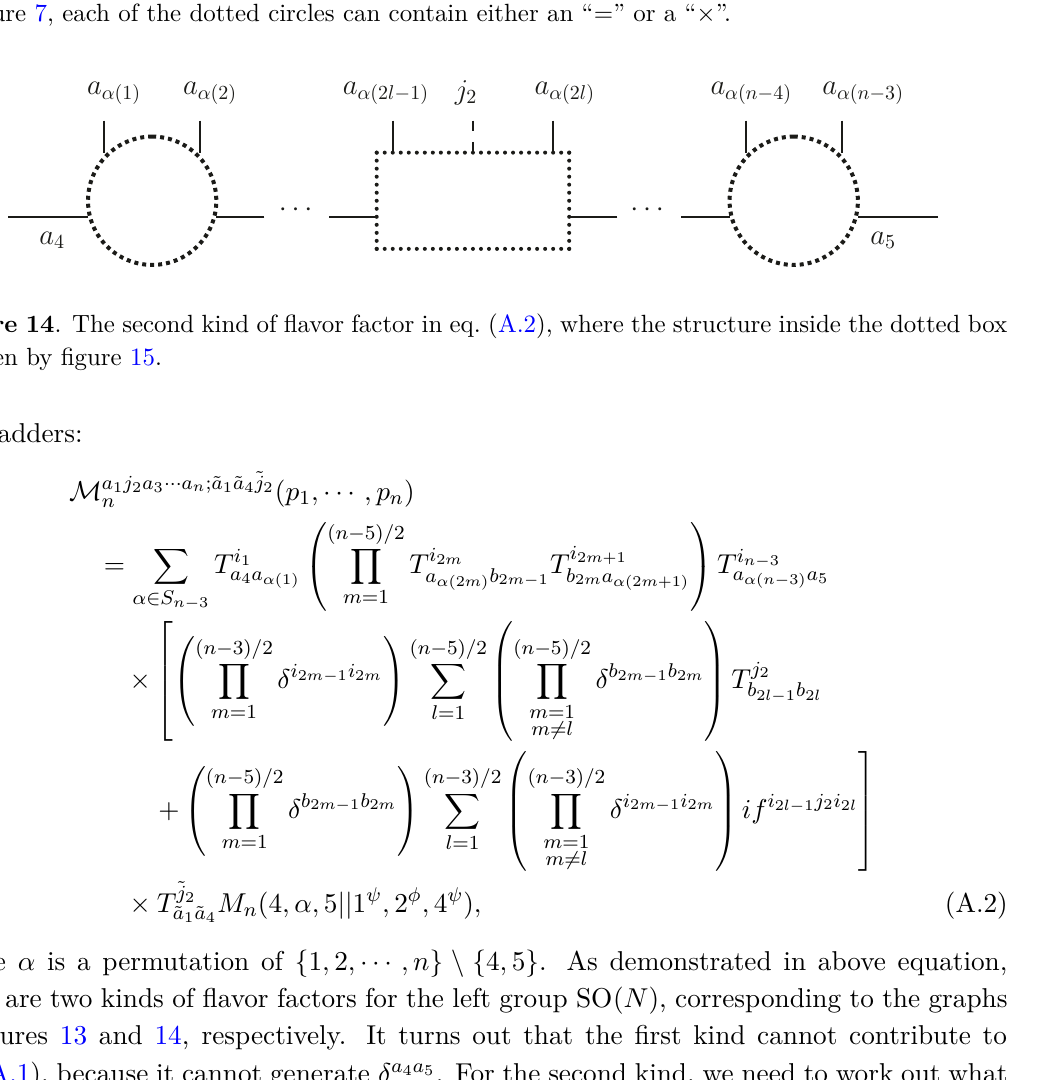
Figure 13 . The first kind of flavor factor in eq. (A.2), which does not generate δ a 4 a 5 . As explained in figure 7, each of the dotted circles can contain either an “ = ” or a “ × ”.